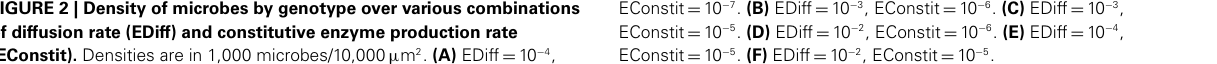
EConstit = 10 − 7 . (B) EDiff = 10 − 3 , EConstit = 10 − 6 . (C) EDiff = 10 − 3 , EConstit = 10 − 5 . (D) EDiff = 10 − 2 , EConstit = 10 − 6 . (E) EDiff = 10 − 4 , EConstit = 10 − 5 . (F) EDiff = 10 − 2 , EConstit = 10 − 5